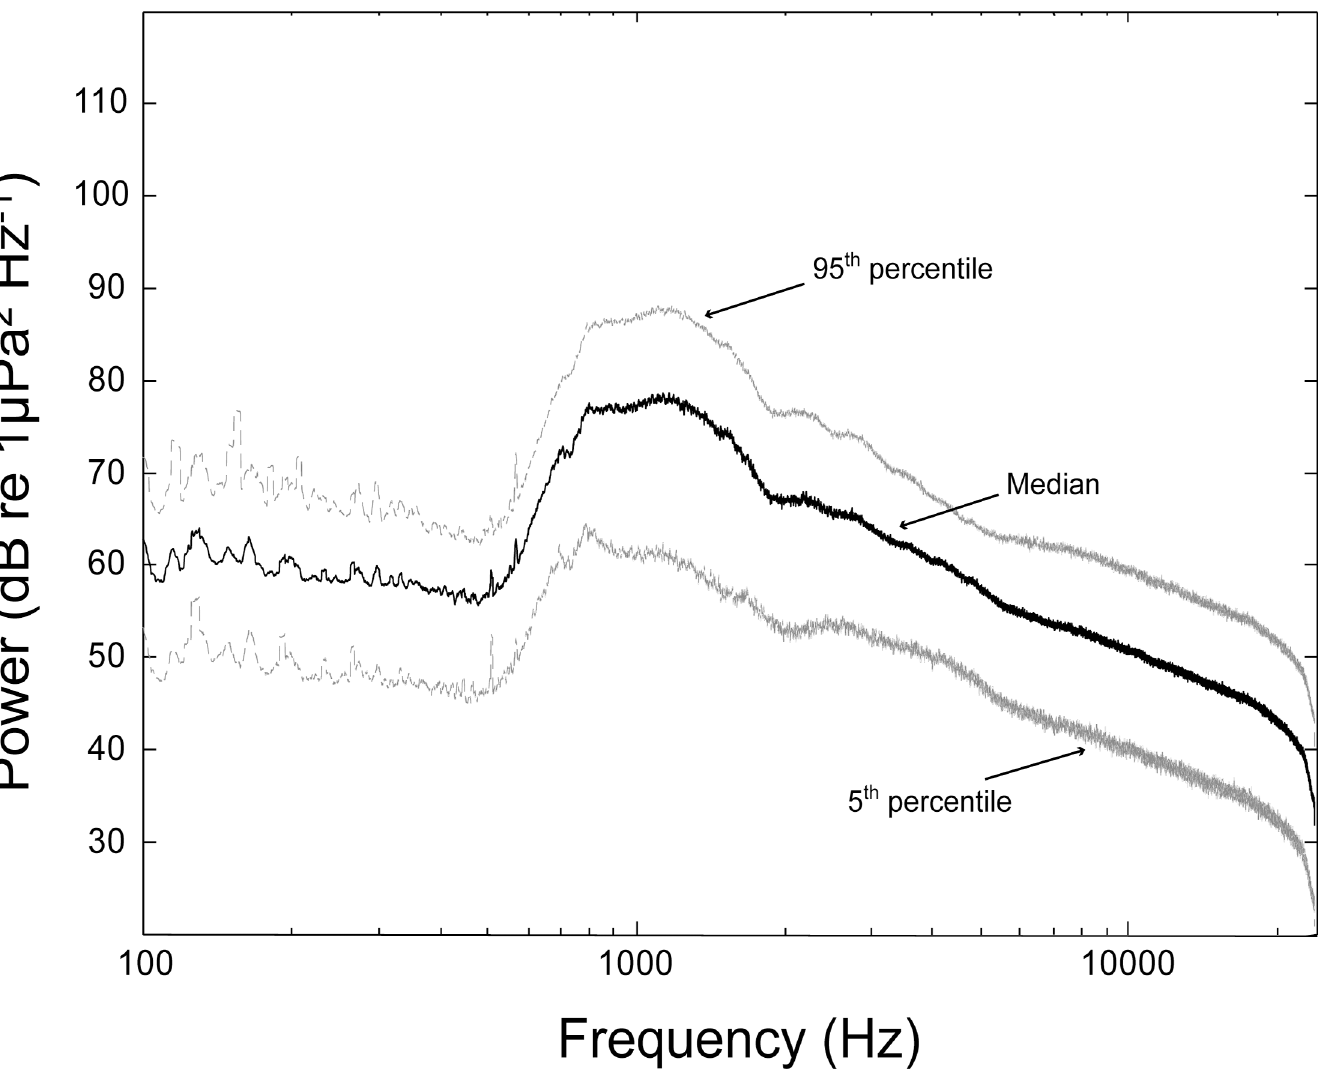
Fig 3. Broadcast sounds from a natural reef habitat. Power spectra of the broadcast sounds from a natural reef habitat during the summer replayed in the Jasus edwardsii behaviour field experiment. Solid black line represents the median spectra for the 6 minute recording and dashed grey lines represent the spectral variability (5 & 95 percentiles) determined from a series of non-overlapping 10 s duration windows (S1 Sound